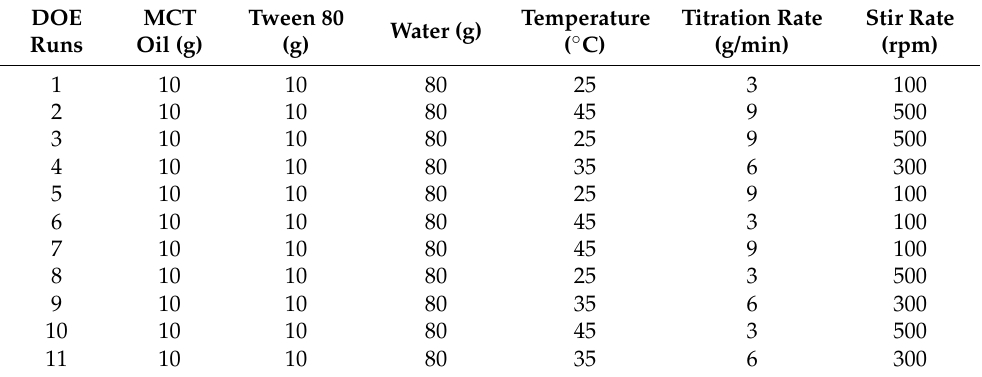
Table 1. DoE for processing conditions of selected